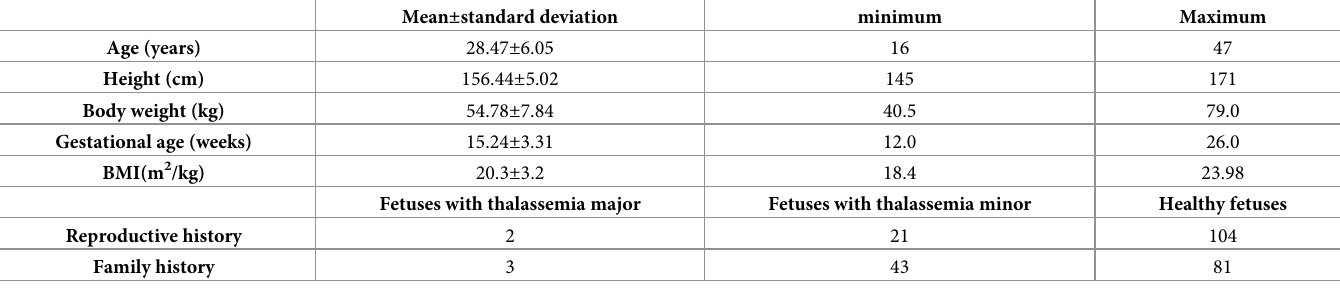
Table 1. Clinical information of enrolled subjects (pregnant women, n = 127).